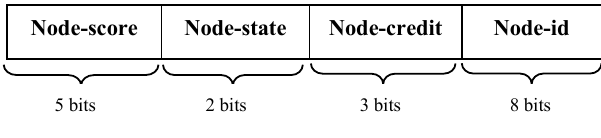
Fig. 1. Information on neighbour nodes.